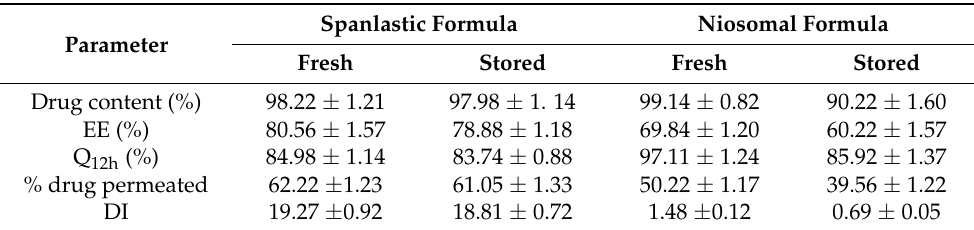
Table 8. Effect of storage at 4–8 ◦ C on the properties of the EGCG-loaded spanlastic formula (F4) and the corresponding niosomal